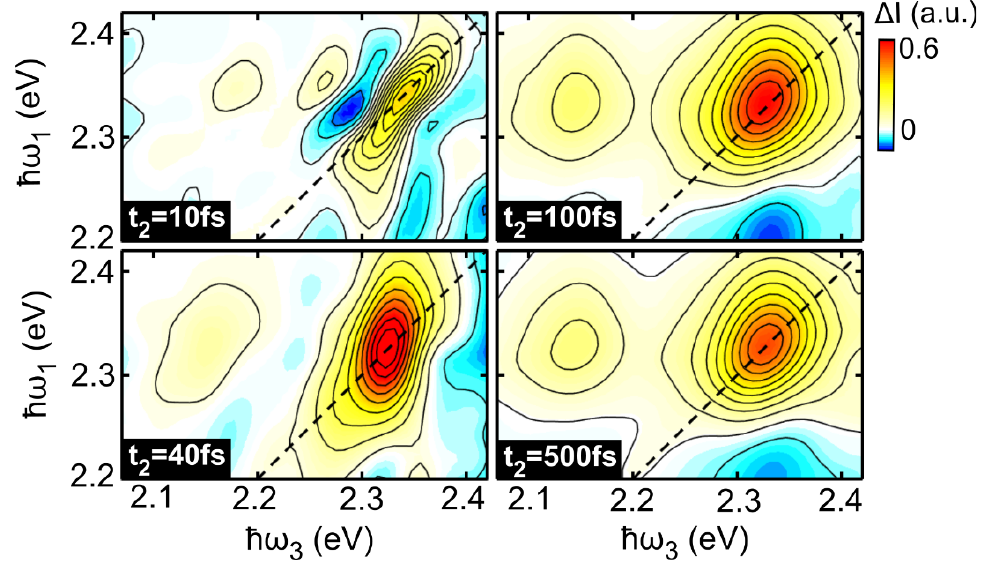
Figure 2. Purely absorptive 2DES maps of 10% LFO in PS at room temperature at population times t 2 = 10 fs, 40 fs, 100 fs and 500 fs. The diagonal is shown using a dashed black